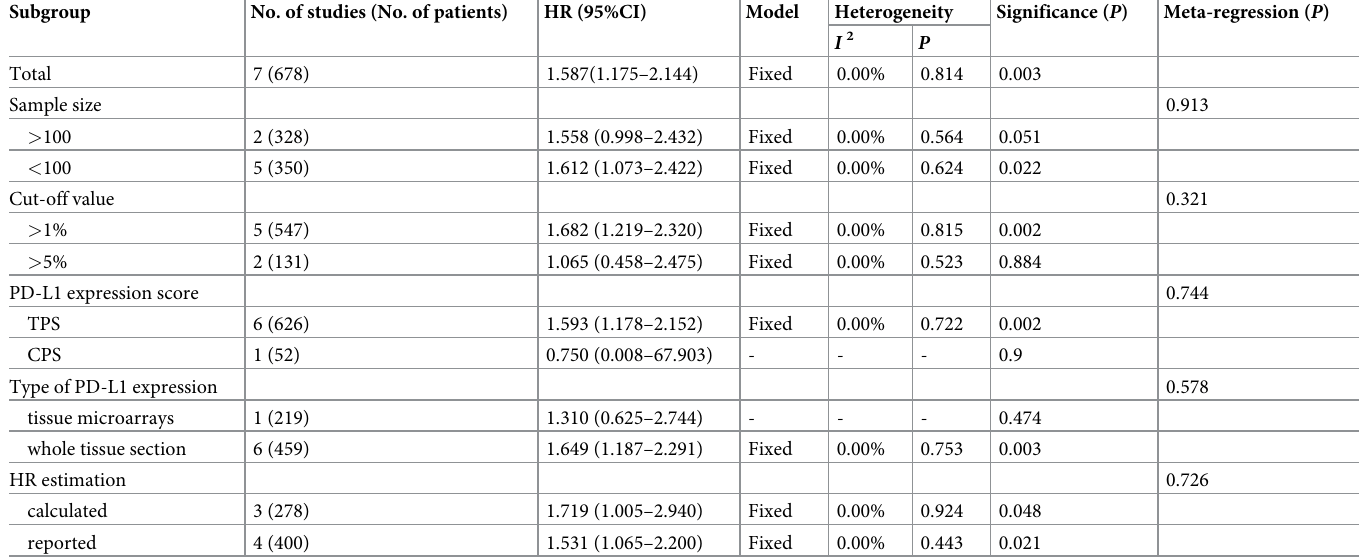
Table 3. Subgroup analyses of survival outcomes based on different factors.